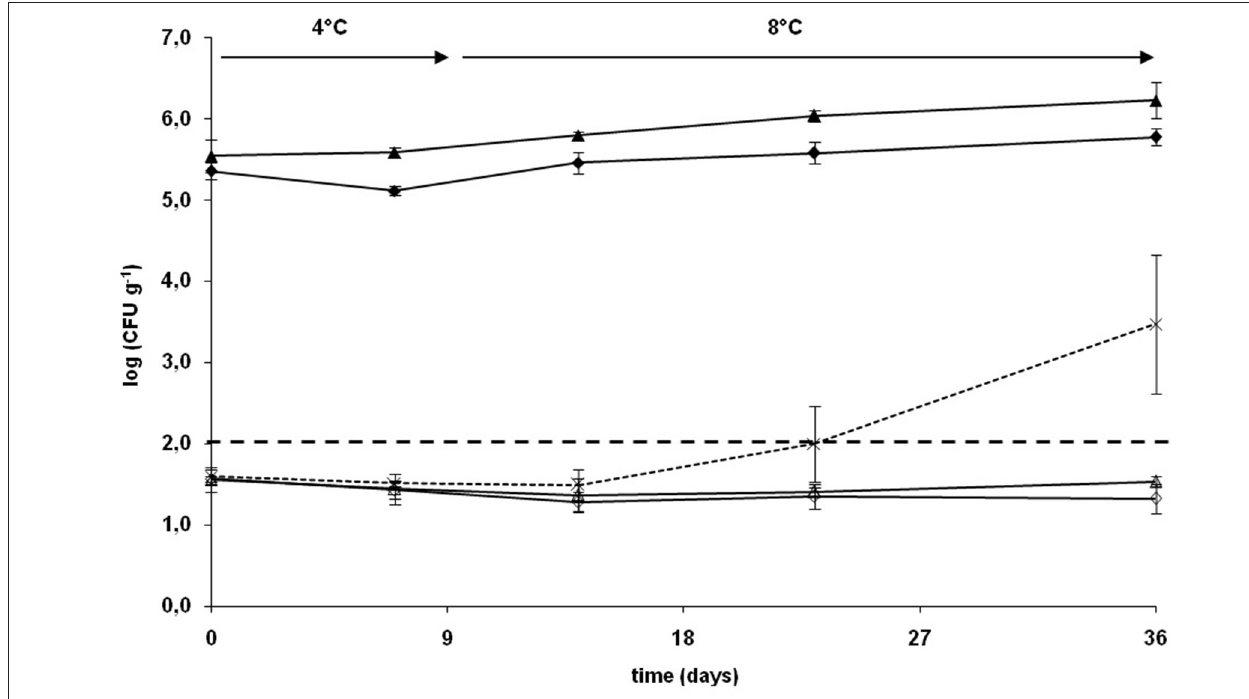
FIGURE 2 | Growth of a mix of five strains of L. monocytogenes alone ( × , dotted lines) and with C. divergens V41 pre-cultured in bioreactor in conditions 1 (15 ◦ C, pH 6.5, 20g/l carbohydrates, △ full line) and 2 (15 ◦ C, pH 6.5, 2g/l carbohydrates, full line ♦ ) in sterile CSS blocks during vacuum storage at 4 and 8 ◦ C. Growth of C. divergens V41 in presence of L. monocytogenes after pre-culture in bioreactor in conditions 1 (full line N ) and conditions 2 (full line (cid:7) ). Each growth curve represents the mean of three enumerations (bars: 95% confidence interval).